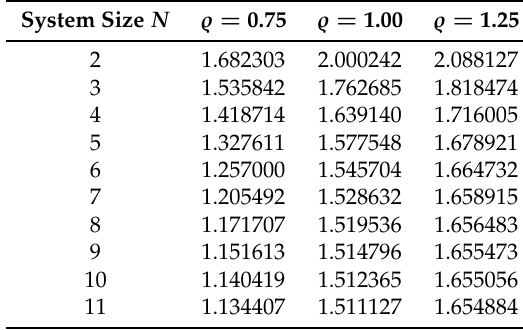
Figure 11. Mean first buffer overflow duration in dependence on offered load and initial buffer state. Table 3. Impact of system size on the mean first buffer overflow duration for different values of offered load.